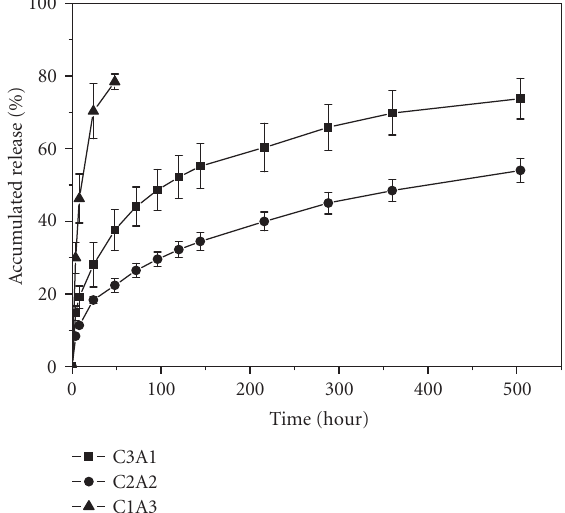
Figure 5: The in vitro release behaviors of curcumin from chitosan- alginate